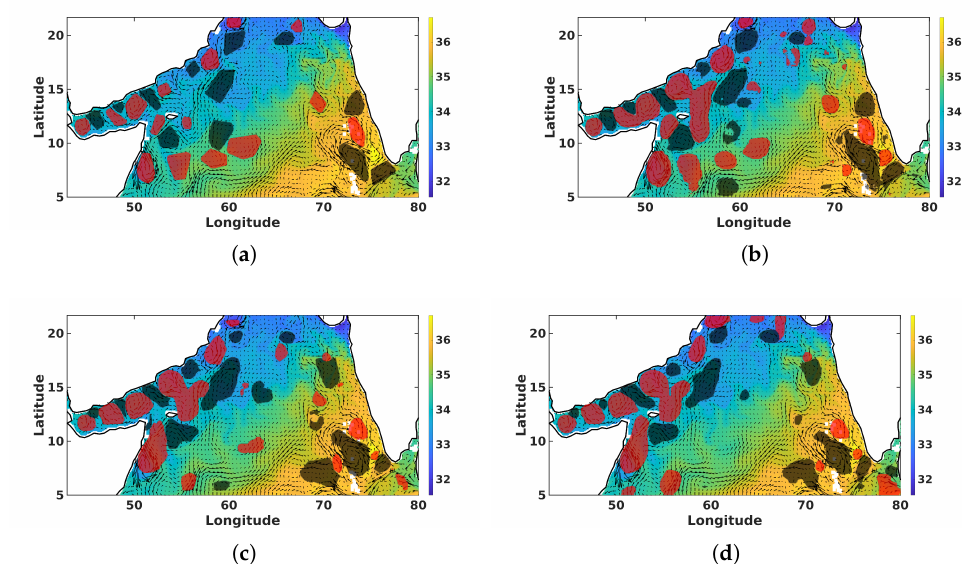
Figure 6. Transfer Learning: Predicted and ground-truth segmentation maps for some randomly selected samples. We obtained these predictions using the fine-tuned ResNet50–FCN model, with all five ocean-surface variables as inputs to the trained model. Cyclonic eddies are colored red and anticyclonic eddies are colored black. The color bars at the sides of each panel indicate the SSH values in meters; ( a ) Reference; ( b ) U-Net–PPM; ( c ) ResNet50–FCN; ( d ) Pretrained